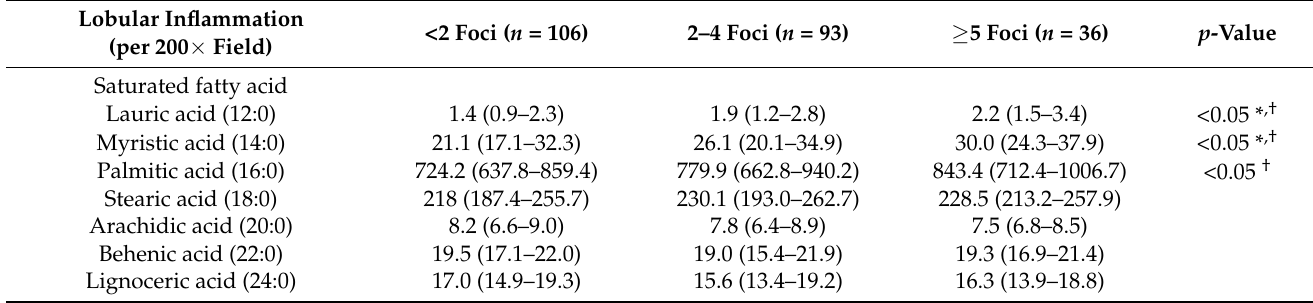
Table 8. Plasma fatty acid composition ( µ g/mL) (lobular